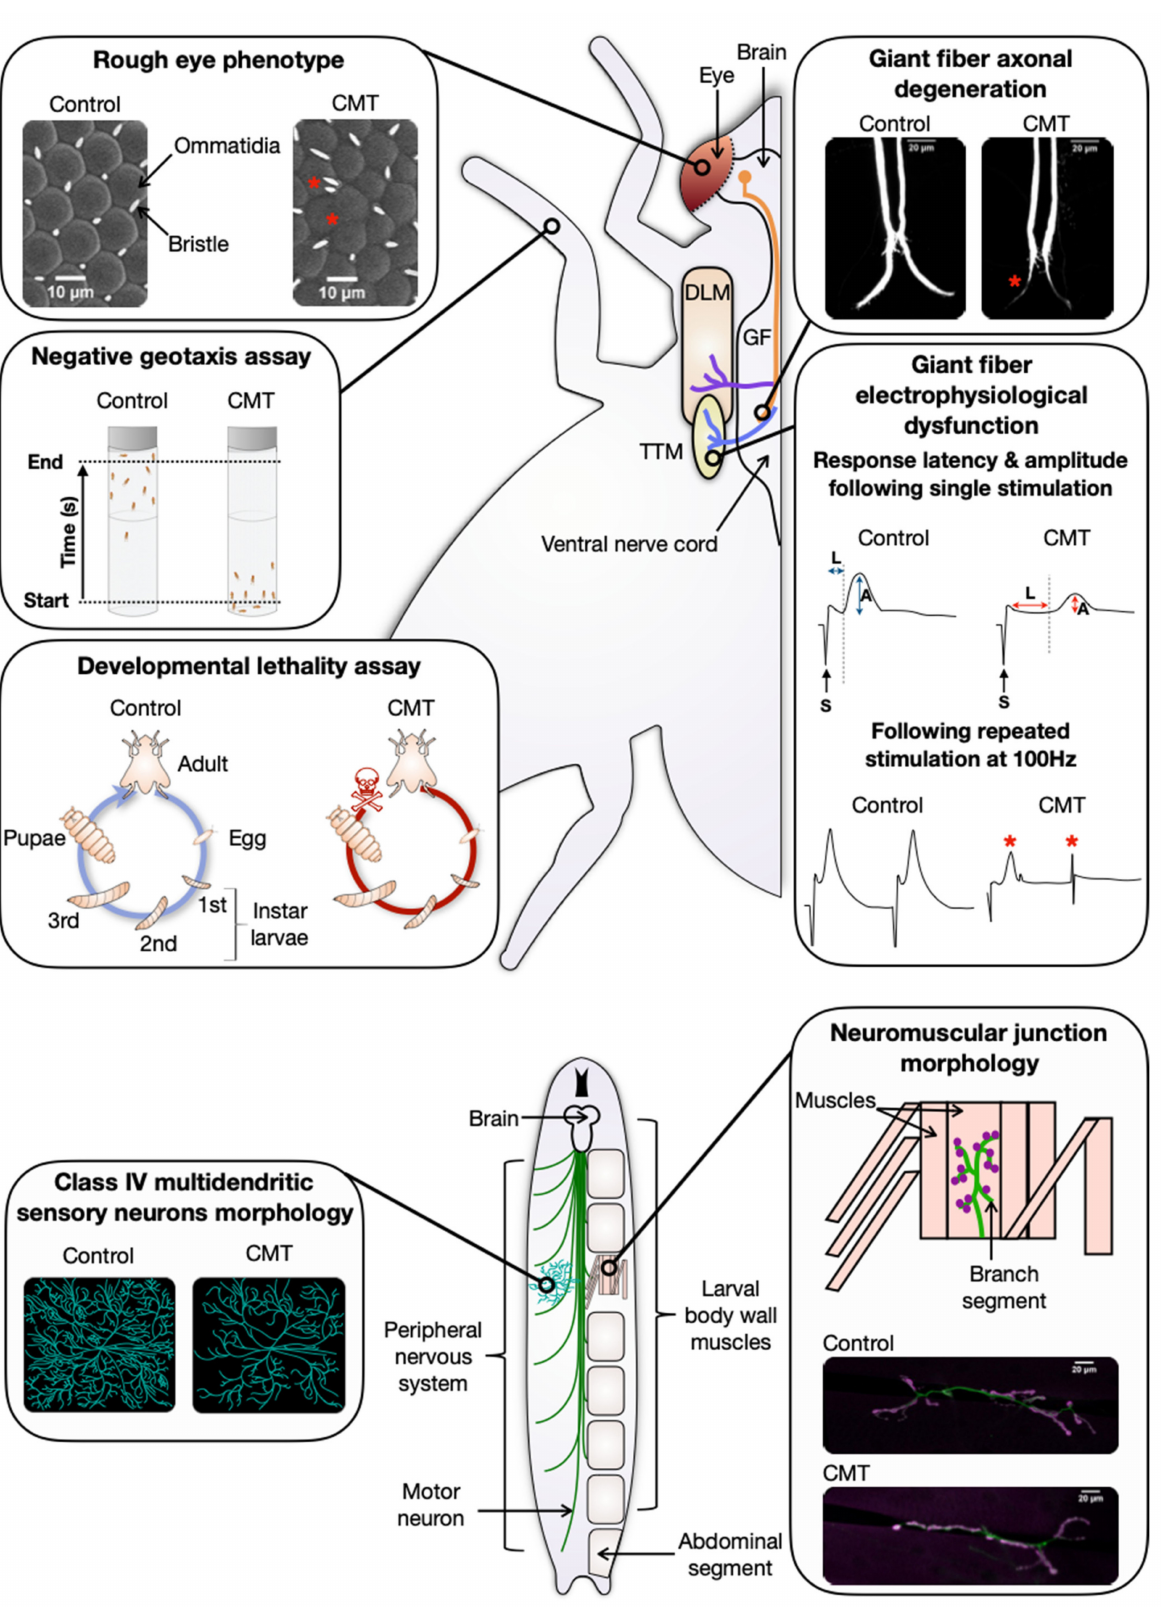
Figure 2. Schematic representation of assays used to evaluate aaRS CMT phenotypes in D. melanogaster . Upper panels: assays performed in adult flies. Lower panels: larval assays. The regular and symmetrical organization of the